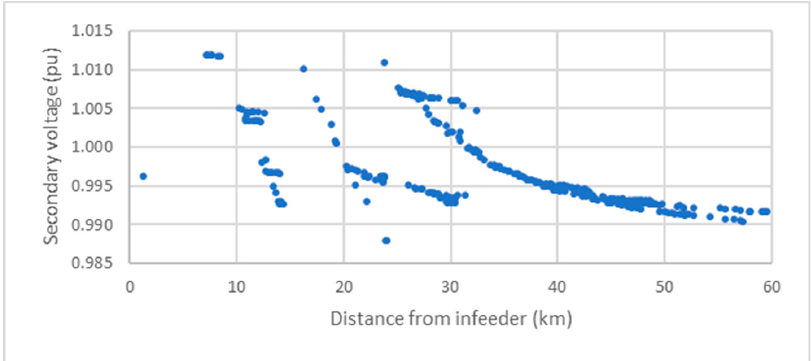
Figure 6. Tap setting against distance from the infeeder for Case 1.1.